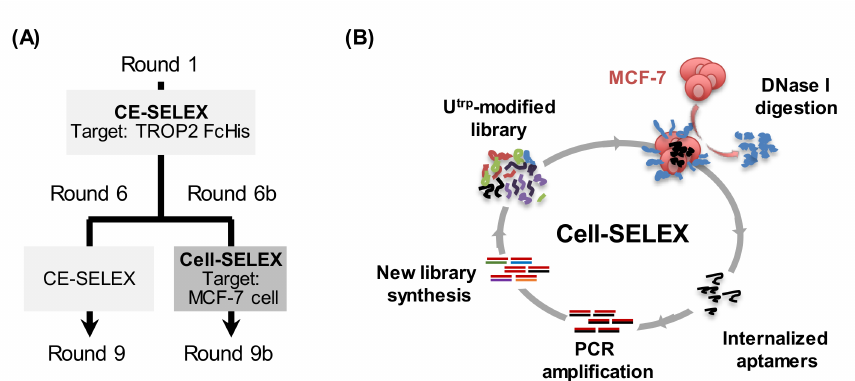
Figure 3. Details of hybrid-type SELEX and schematic representation of cell-SELEX. ( A ) The process flow of hybrid-type SELEX (the combination of CE-SELEX and cell-SELEX). Five rounds of CE-SELEX were performed against TROP2 FcHis protein, and then the selection process was classified into two types (CE-SELEX and cell-SELEX). CE-SELEX was performed from round 6 to 9, and cell-SELEX was performed from round 6b to 9b, to target MCF-7 cells. ( B ) The cell-SELEX scheme for the selection of U trp modified aptamers that could be internalized into MCF-7 cells is shown. The cell surface-binding aptamers were digested using DNase I in the iterative selection flow.